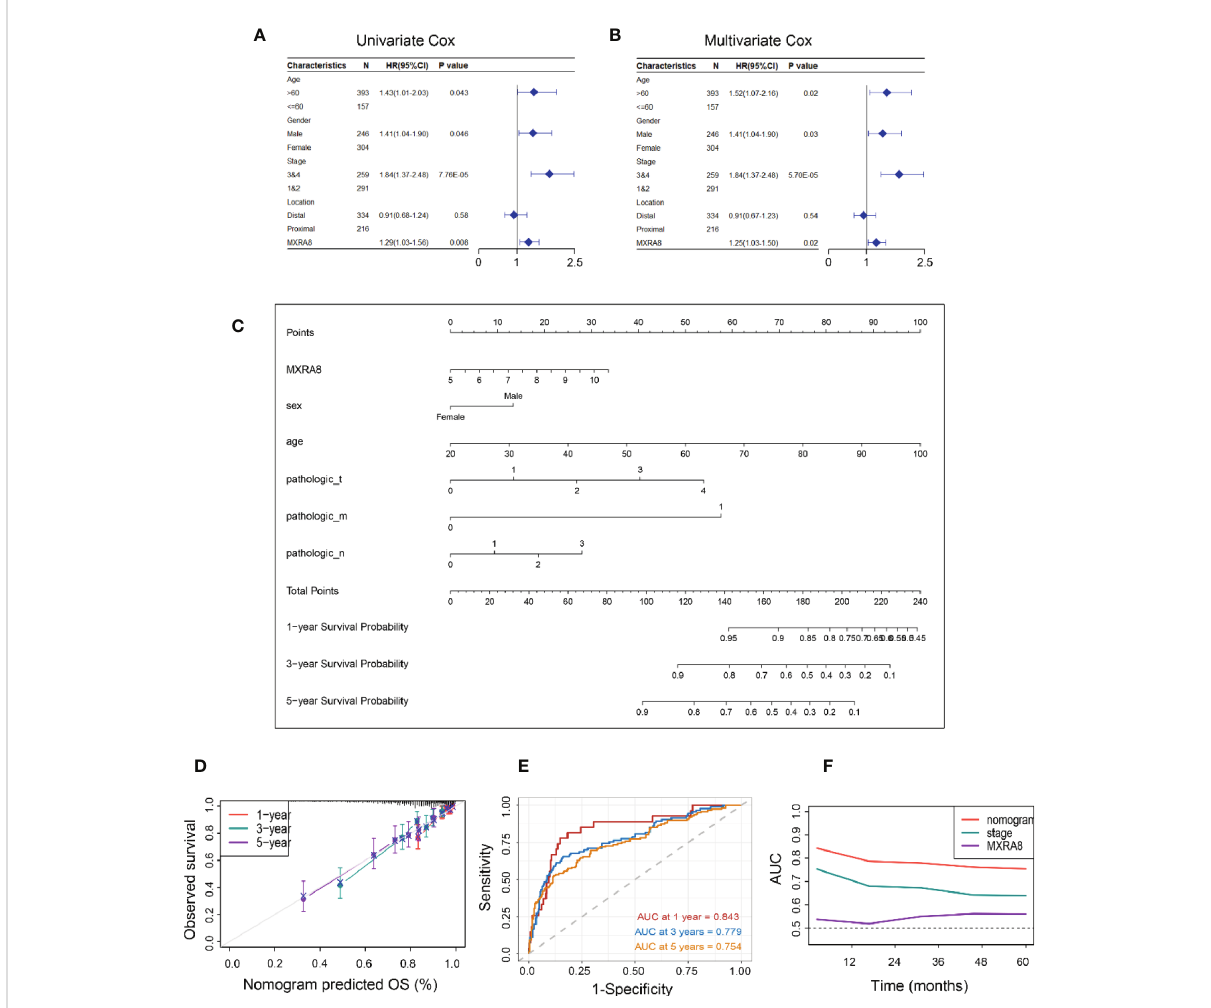
FIGURE 3 Constructing an MXRA8-based prognostic prediction model. (A) Univariate Cox regression analysis of MXRA8 and clinicopathological characteristics (B) Multivariate Cox regression analysis of MXRA8 and clinicopathological characteristics. (C) Nomogram developed based on MXRA8 and clinicopathological characteristics. (D) Plots depict the calibration of the model regarding the agreement between predicted and observed OS. Model performance is shown by the plot relative to the 45-degree line, representing perfect prediction. Calibration analysis of the agreement between nomogram predicted 1-, 3-, and 5-year survival and observed outcomes. (E) Time-dependent ROC curves at 1, 3, and 5 years of the nomogram. (F) AUC plotted for different durations of OS for nomogram-based signature, tumor stage, and MXRA8 in TCGA